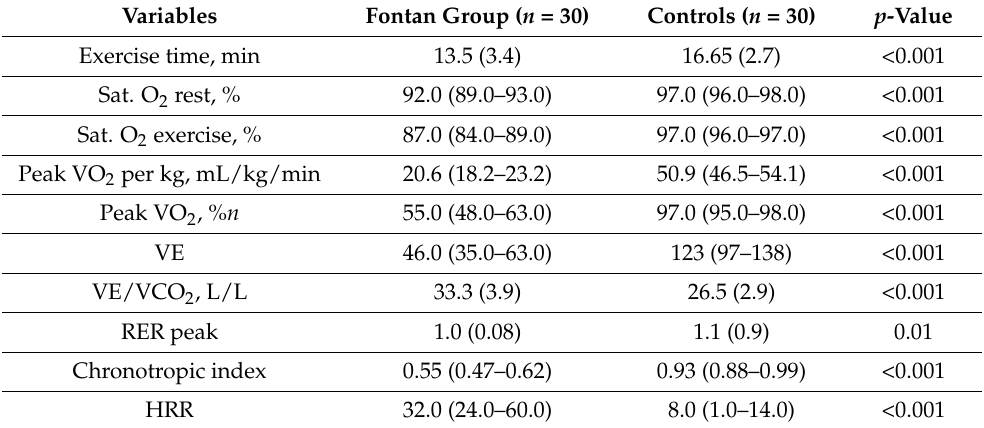
Table 4. Cardiopulmonary exercise test results of patients in the Fontan operation group and controls.